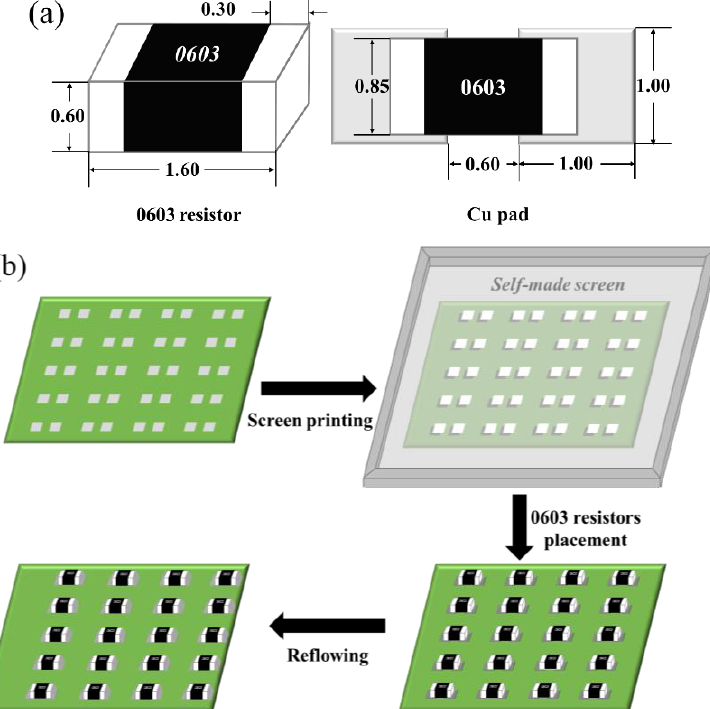
Figure 1. Schematic diagrams of ( a ) dimensions of the 0603 chip resistor and Cu pad (unit: mm) and ( b ) solder joints ’ preparation.